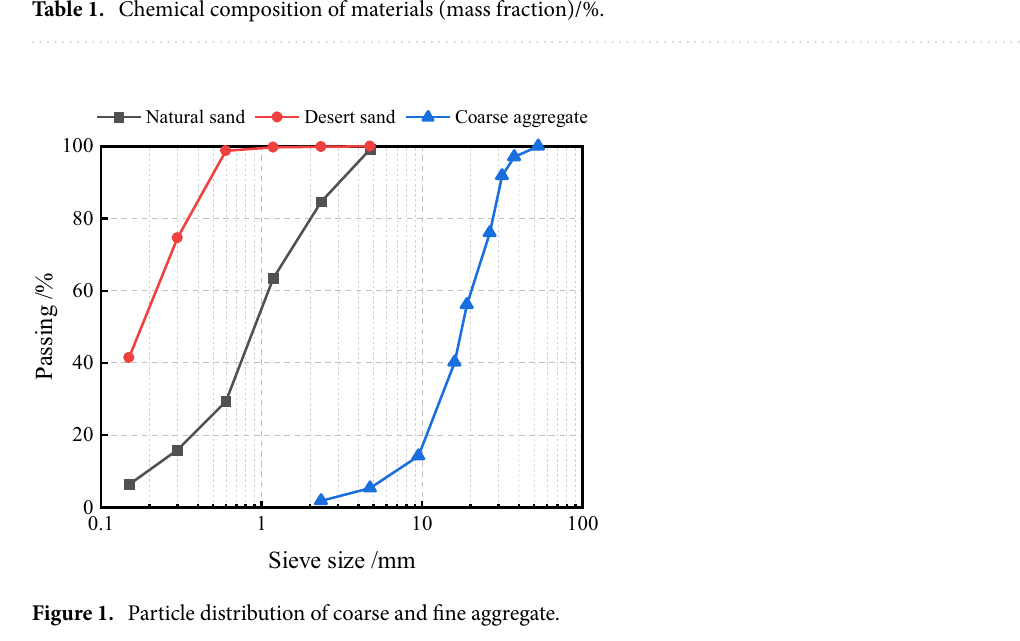
Table 1. Chemical composition of materials (mass fraction)/%.